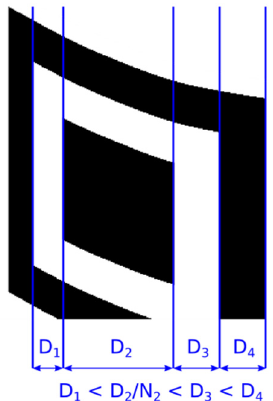
Figure 19. Variable-sized modules.